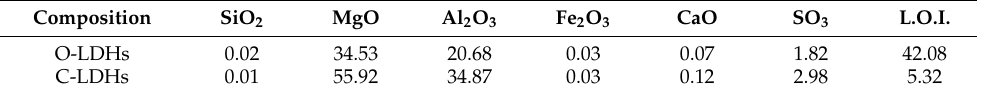
Table 2. Chemical and mineralogical compositions of Mg-Al layered double hydroxides (wt.%).